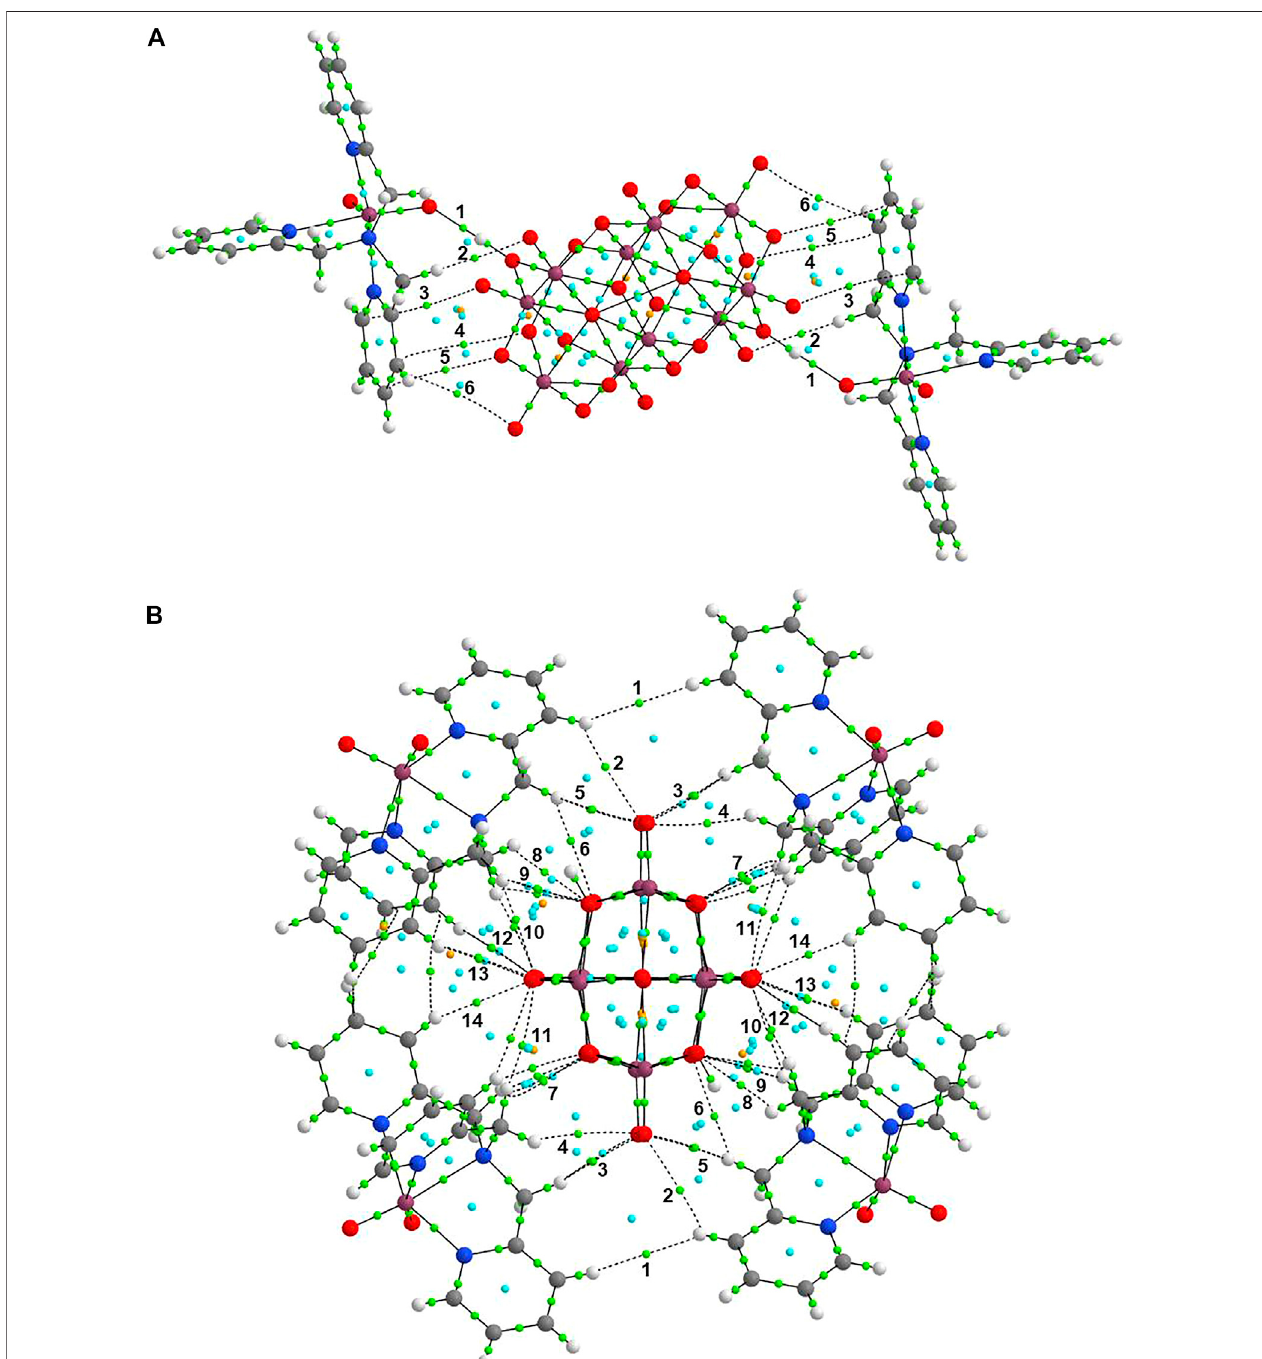
FIGURE 7 | Molecular graphs of (A) the representation of Compound 1 forming hydrogen bonds connecting both species of V(V), and (B) the asymmetric unit showing to the diprotonated decavanadate unit and four dioxidovanadium(V)-tpma moieties.